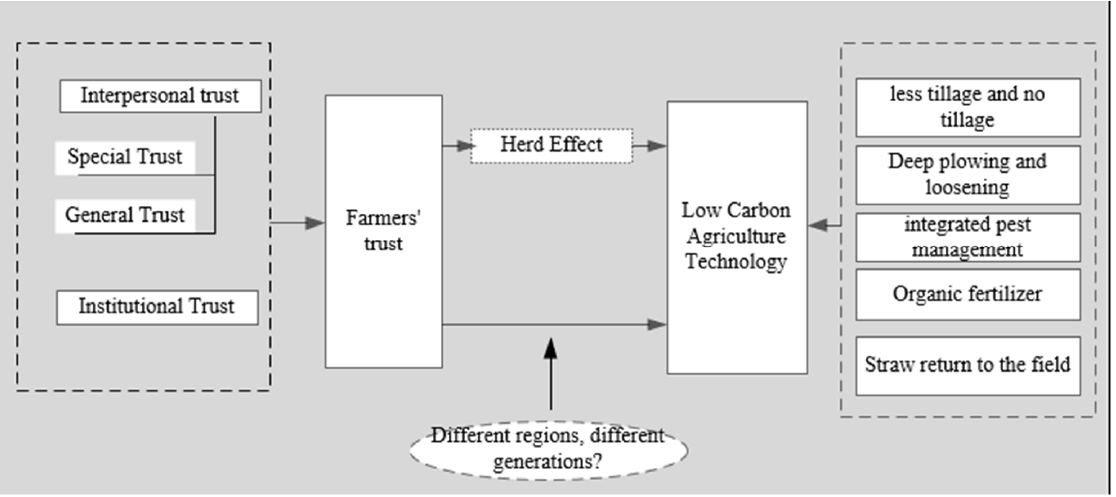
Figure 1. Research framework diagram.